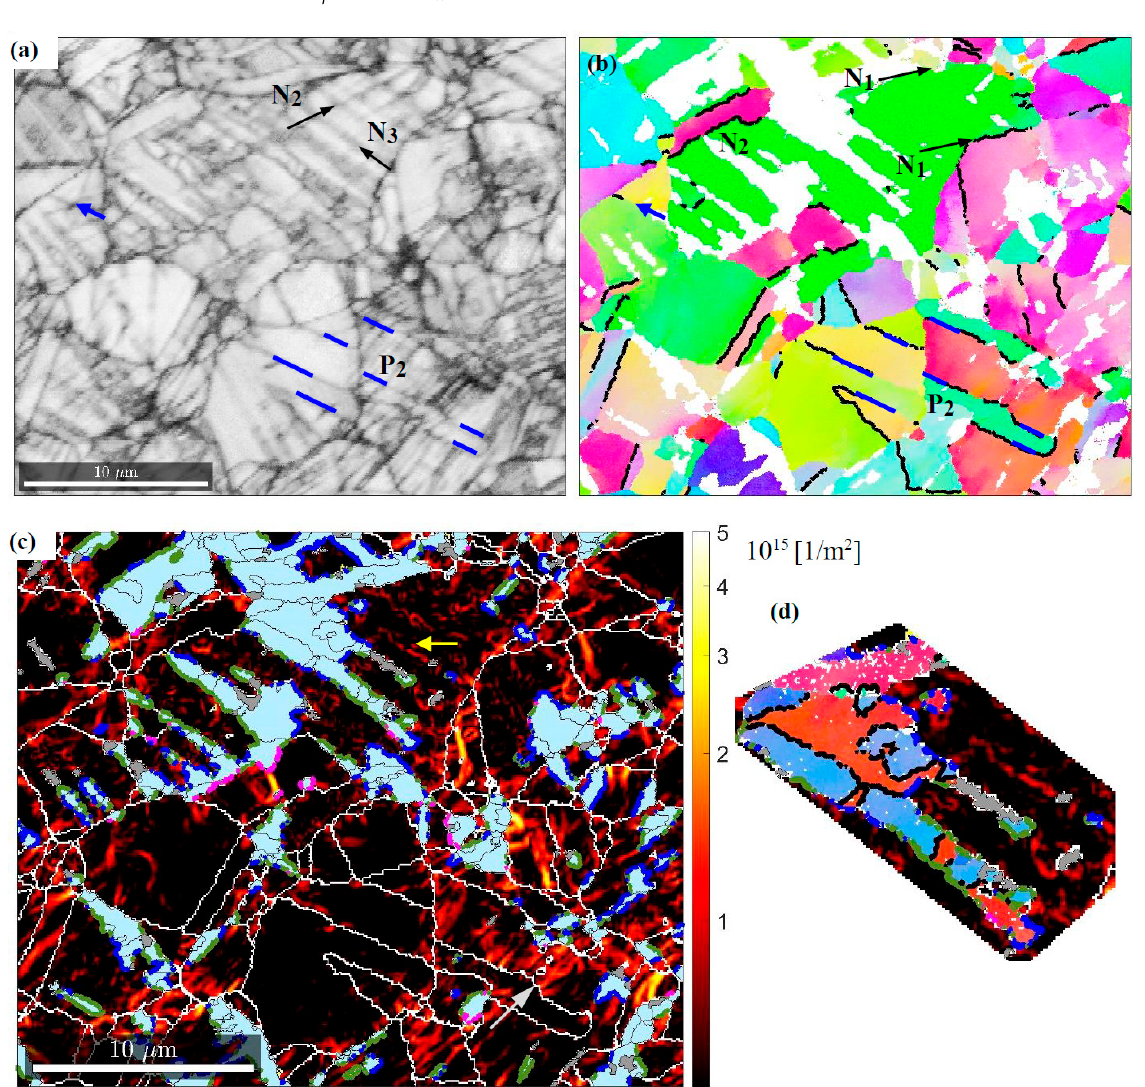
Figure 10. Microstructure of the representative region located 2 mm from the fracture surface. ( a ) Image quality map of austenite matrix with arising α ’ martensite (blue) and ε martensite (green). ( b ) {1 1 1} pole figure for austenite and its two most preferred orientations (P, N).